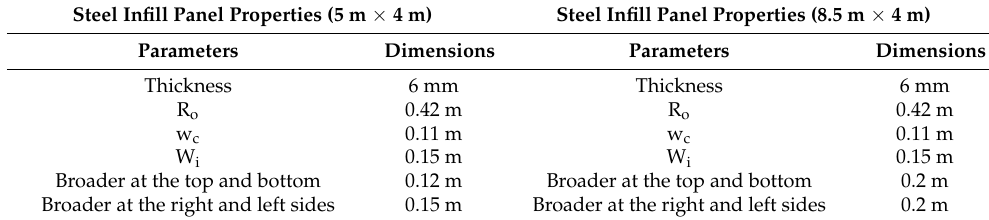
Table A2. Ring-Shaped Infill Panel